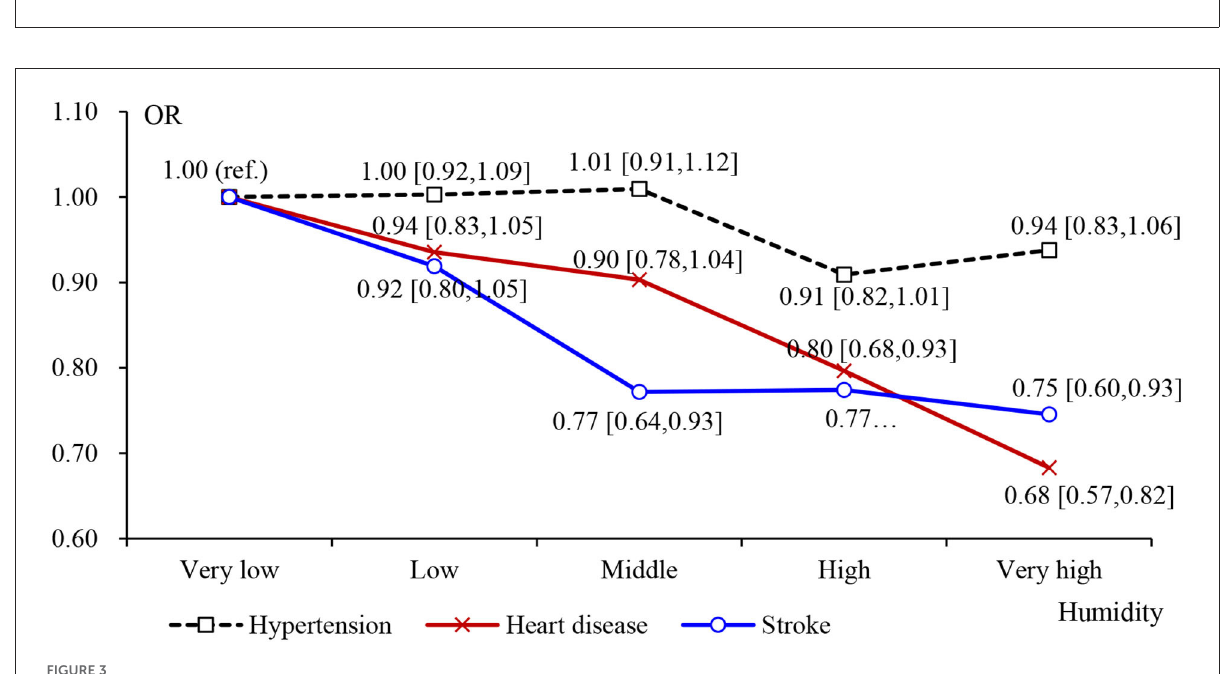
FIGURE3 Effects of categorical average humidity on CVD: Odds ratios (OR) in Table